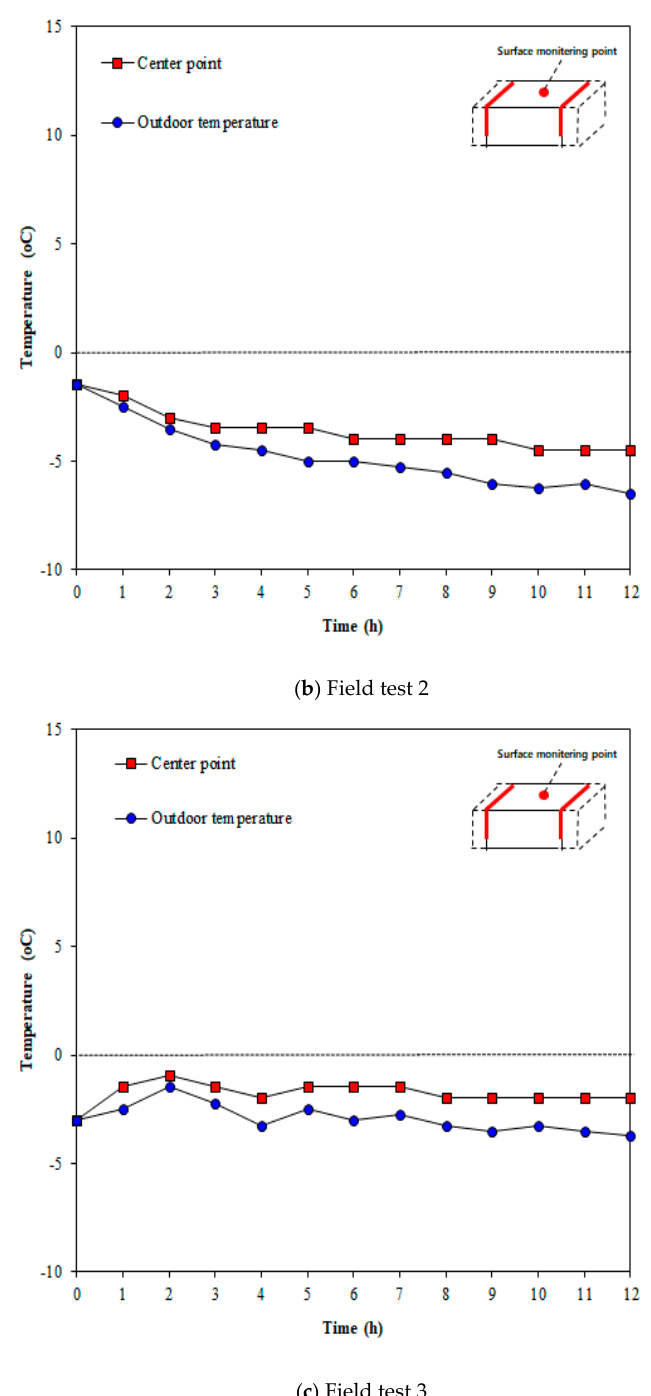
Figure 16. Temperature at center vs. outdoor temperature (Line 2).